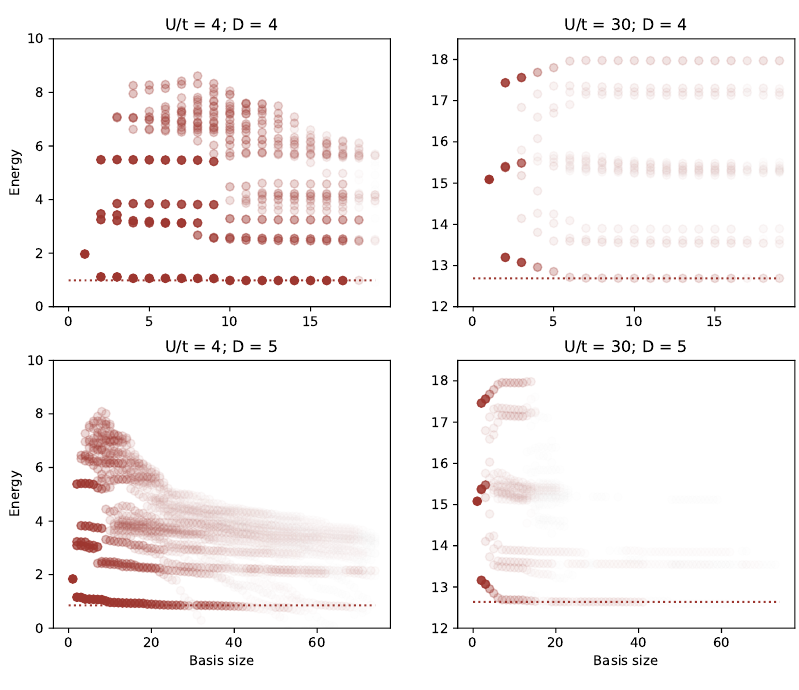
Figure 5: Eigenvalues as a function of basis size, where for each value the gener- alized eigenvalue problem is solved using a reduced subspace based on the largest eigenvectors of the norm overlap matrix. The opacity of each points is proportional to the corresponding